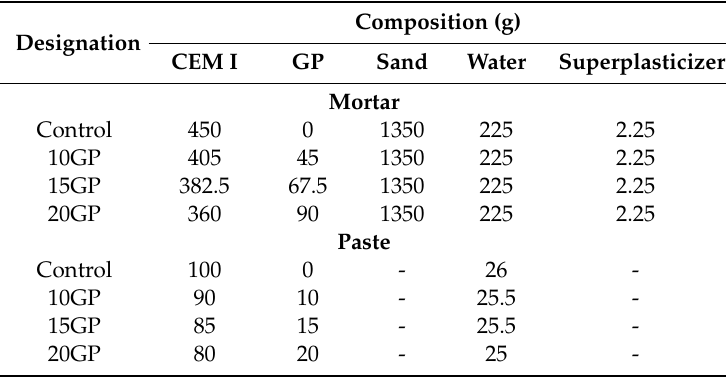
Table 1. Composition of cement mortars and